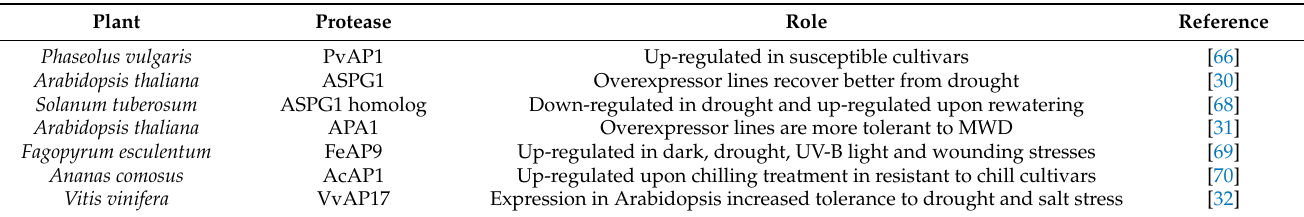
Table 1. Aspartic proteases involved in abiotic stress